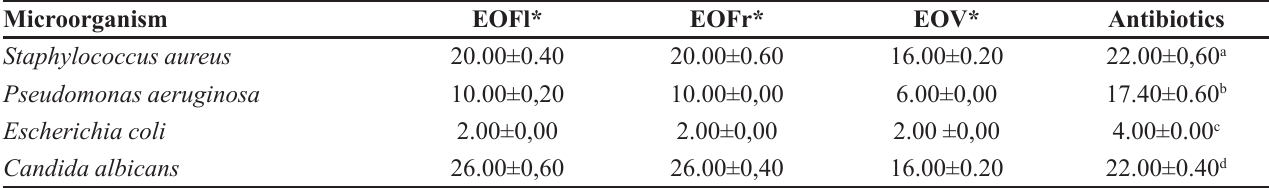
TABLE III - Antimicrobial activity of the essential oil from Campomanesia adamantium leaves Microorganism Staphylococcus aureus